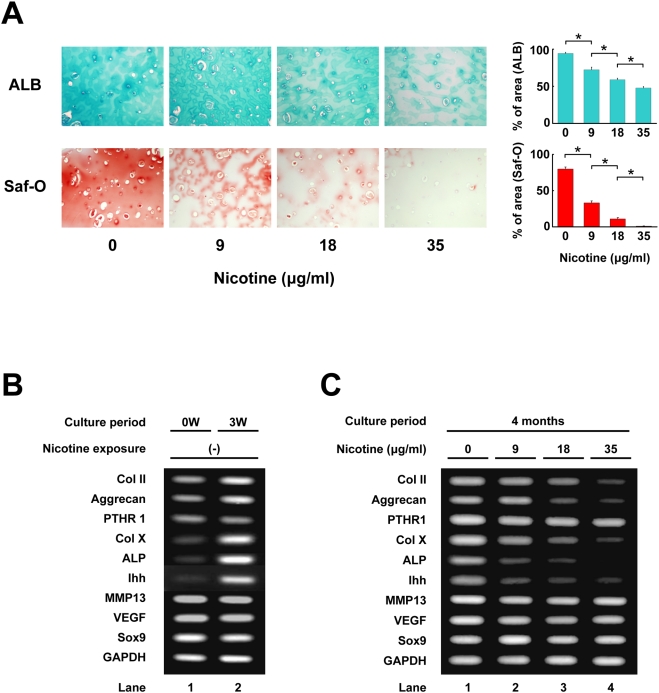
Long-term (four months) effect of nicotine on growth plate chondrocytes in alginate beads.Growth plate chondrocytes in alginate beads were exposed to the indicated concentration of nicotine for four months. A: Microscopic view of chondrocytes in alginate beads after four-months cultivation. Upper panels: ALB stain, lower panels: Safranin-O stain. Chondrocytes were surrounded by matrix which they secreted. Nicotine decreased the area stained with ALB or Safranin-O in a concentration-dependent manner. *, statistically significant, P<0.02. B: RT-PCR analysis of chondrocyte-specific gene expression in the chondrocytes at the start of cultivation (lane 1: 0W) and three weeks (lane 2: 3W). From top to bottom: genes for Col II, Aggrecan, parathyroid hormone receptor type 1 (PTHR1), Col X, alkaline phosphatase (ALP), Indian hedgehog (Ihh), matrix metalloproteinase type13 (MMP13), vascular endothelial growth factor (VEGF), Sox9 and GAPDH. C: RT-PCR analysis of chondrocyte-specific gene expression in chondrocytes embedded in alginate beads exposed to the indicated concentration of nicotine for four months. Expression of early stage matrix-gene (Col II and Aggrecan) and markers of hypertrophic chondrocytes (Col X, ALP and Ihh) increased after three weeks of cultivation (B). Nicotine decreased the expression of these genes in a concentration-dependent manner, but had little effect for the expression of MMP13, VEGF, and control genes (Sox9 and GAPDH) (C).